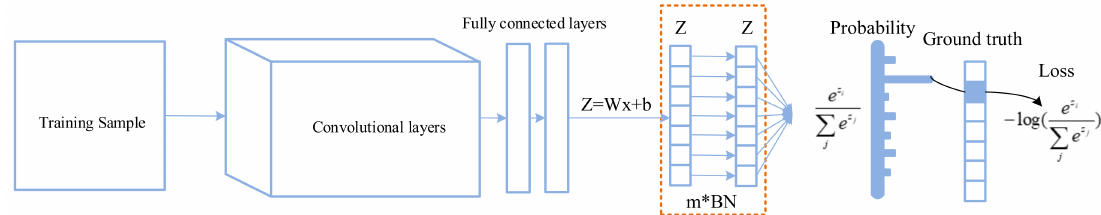
Figure 1. Traditional training process for classification tasks and new scaled Batch Normalization (BN)